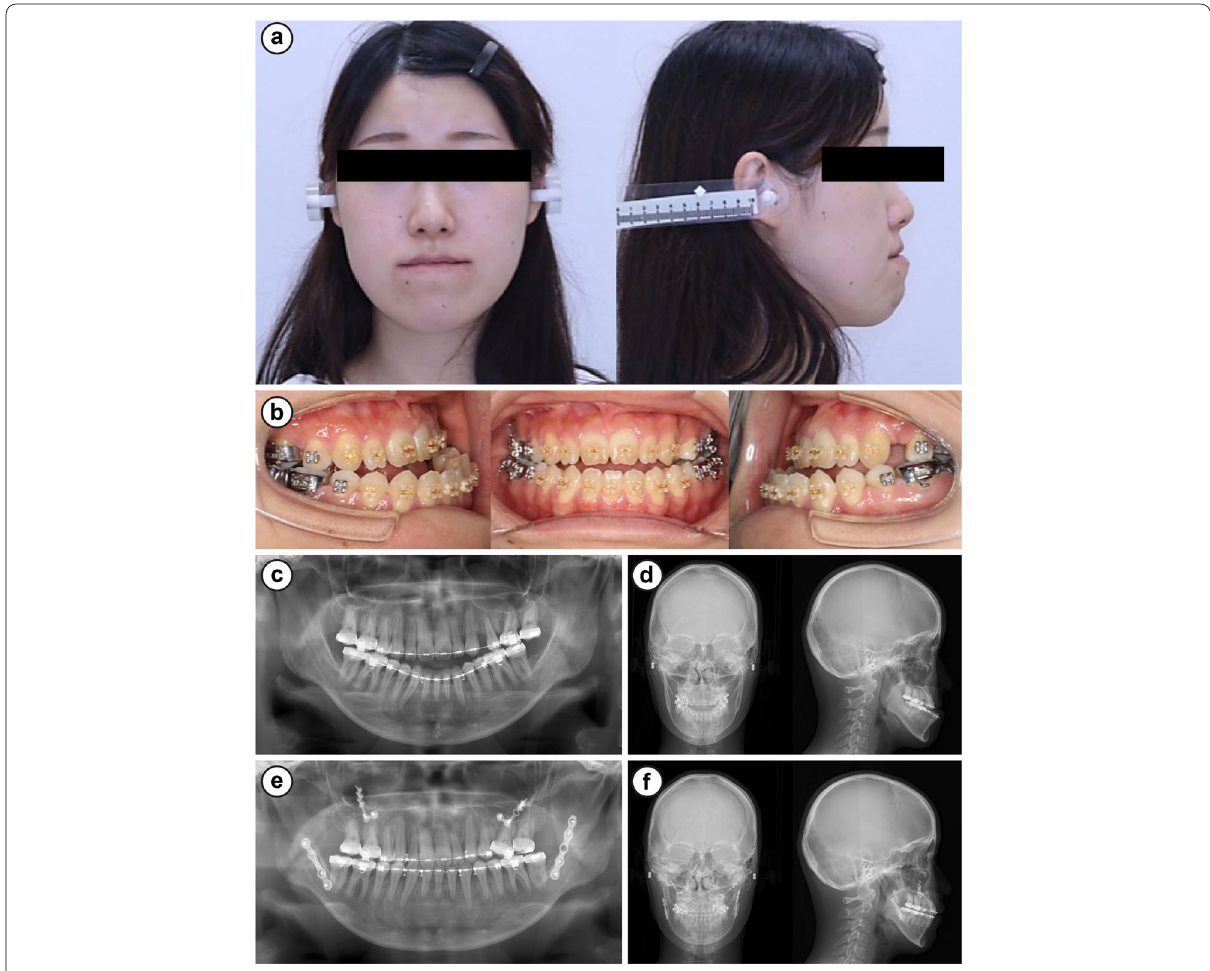
Fig. 3 Case 10. a Facial photographs, b intraoral images, c panoramic radiographs, d cephalometric radiogram, e panoramic radiographs 1 year 6 months postoperatively, and f cephalometric radiogram 1 year 6 months postoperatively